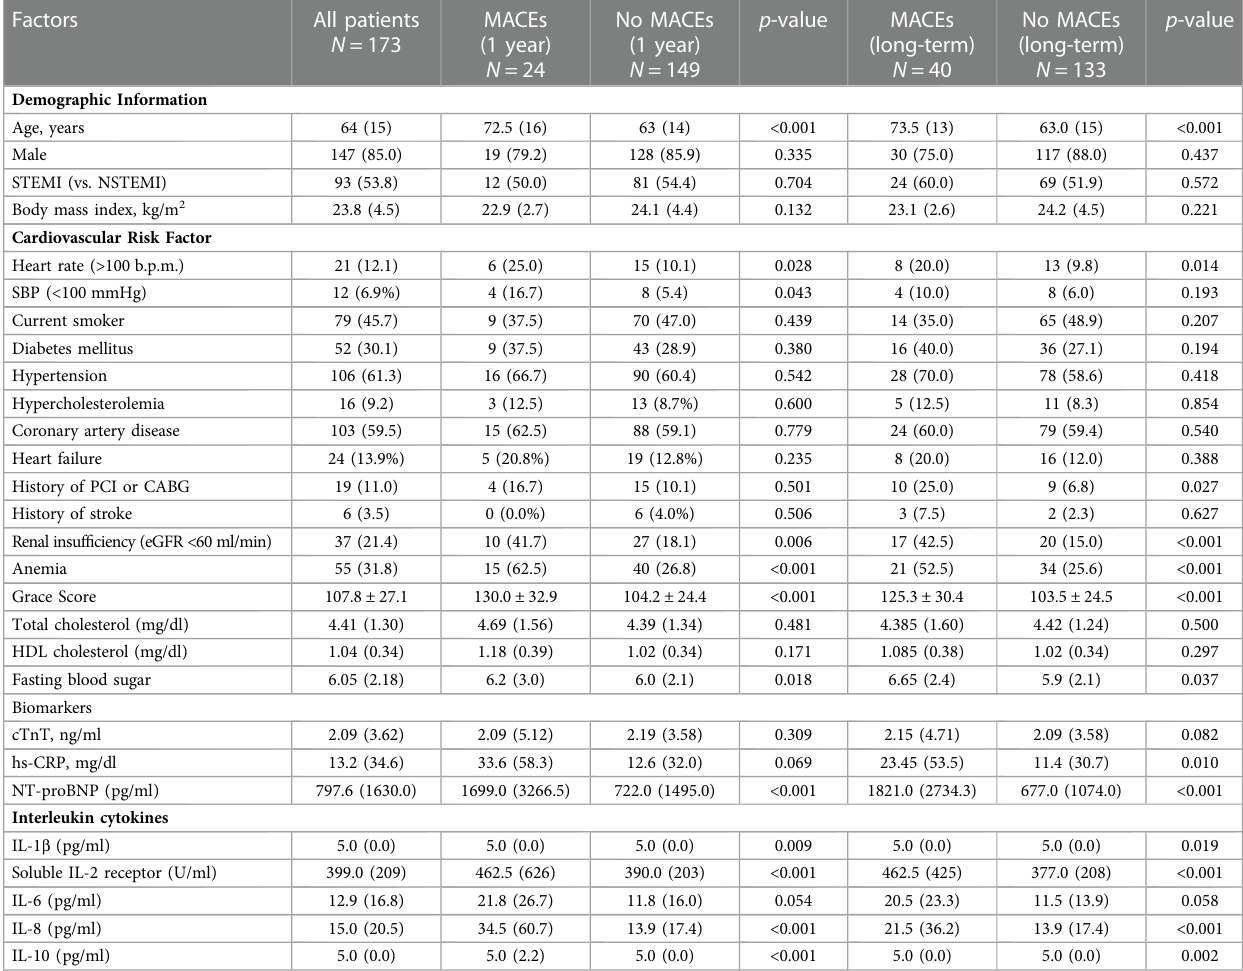
TABLE 1 Clinical and demographic characteristics of patients according to MACEs during 1-year and long-term follow-up.